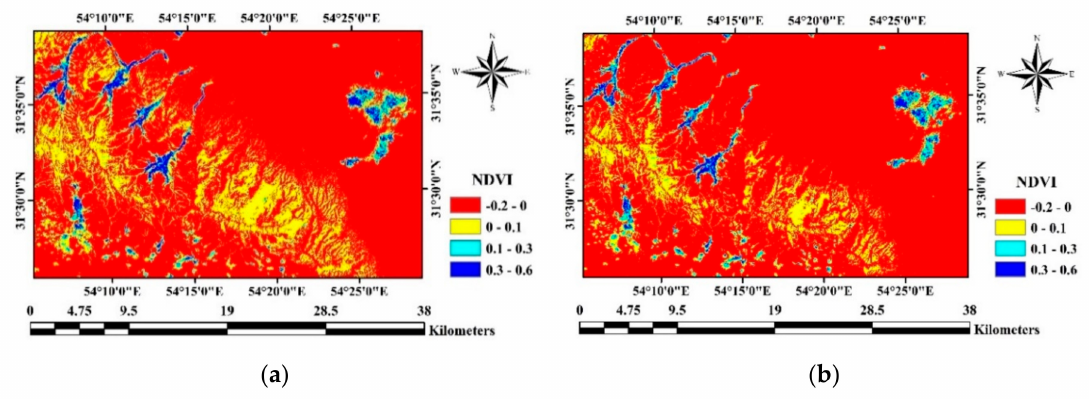
Figure 18. Reconstructed image by HANTS algorithm ( a ) and M-SSA algorithm ( b